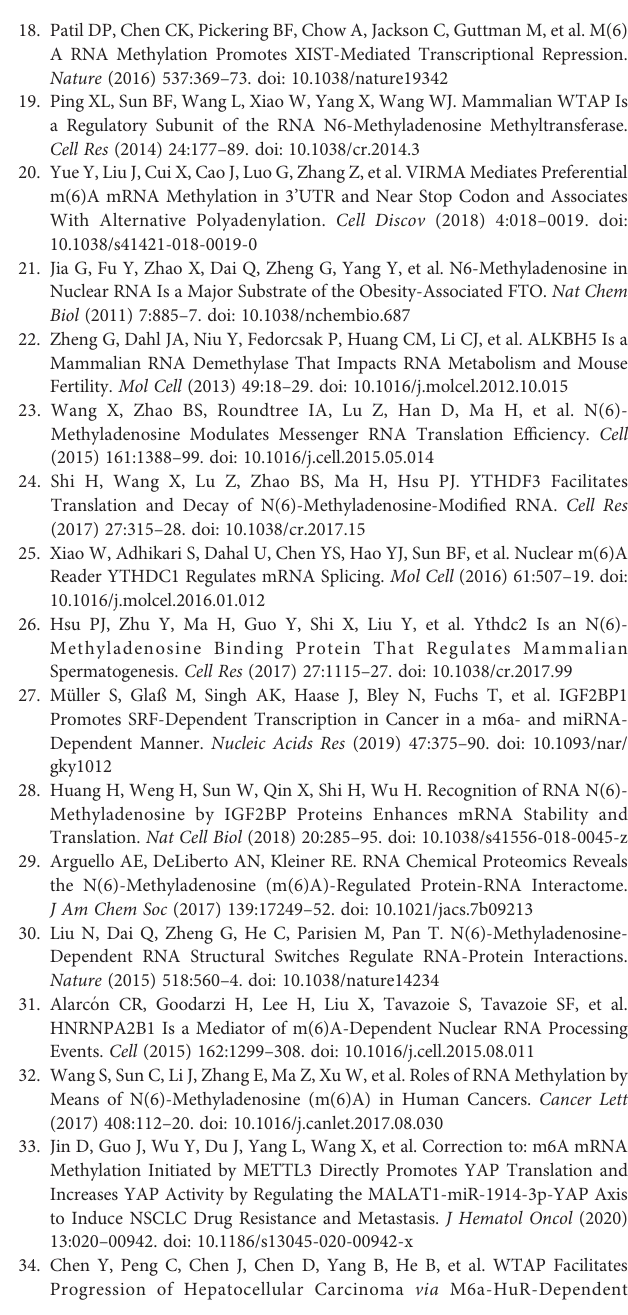
Supplementary Figure S4 | External validation of the m 6 A score model in lung adenocarcinoma patients from GSE11969, GSE13213, GSE37745, and GSE50081 datasets. (A) Kaplan-Meier curves showing the differences in survival of the high and low m 6 A score groups in GSE11969 (P = 0.002, Log-rank test). (B) Kaplan-Meier curves showing the differences in survival of the high and low m 6 A score groups in GSE13213 (P = 0.002, Log-rank test). (C) Kaplan-Meier curves showing the differences in survival of the high and low m 6 A score groups in GSE37745 (P = 0.032, Log-rank test). (D) Kaplan-Meier curves showing the differences in survival of the high and low m 6 A score groups in GSE50081 (P < 0.001, Log-rank